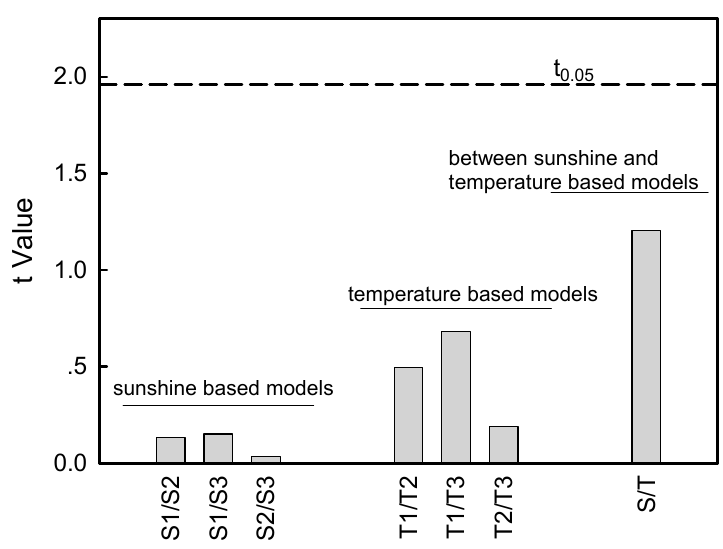
Figure 2. Values of t -statistic test between and within the results from the sunshine- and temperature-based model. S1, S2, S3 denote the sunshine-based model Angstrom, Ogelman and Bahell, respectively. T1, T2, T3 denote the temperature-based model Bristow, Hargreaves and Chen, respectively.